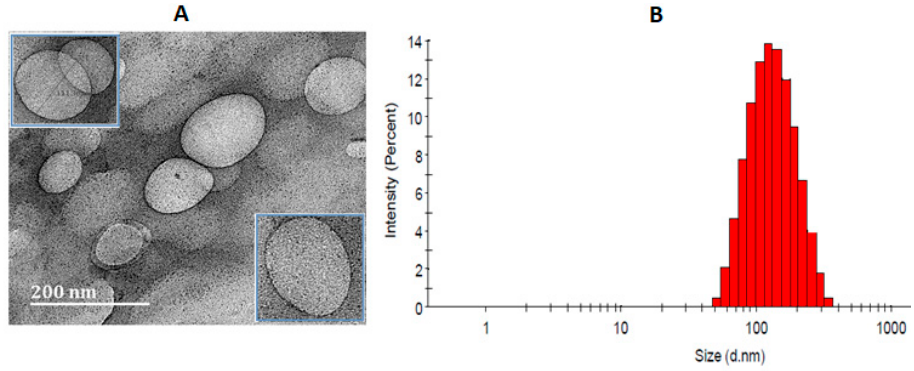
Table 1. MHD, PDI, ζ , DEE%, and DLC% of initial screening VCM-StAclm-Qt quatsomes. CHol: StBAclm (mg/mL)